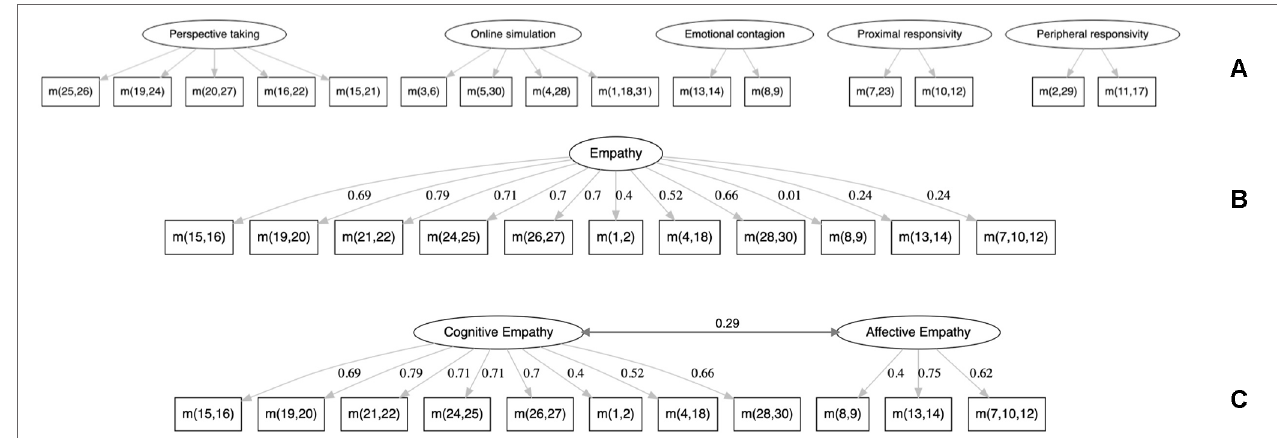
FIGURE 1 | The three confirmatory factor analysis (CFA) models tested. (A) Five-factor first-order structure from (4). (B) Unique-factor first-order structure, without peripheral responsivity and parcellations, from (9). (C) Two-factor first-order structure from (9). m ( x,y,z ) signifies the mean of items x , y , and z .